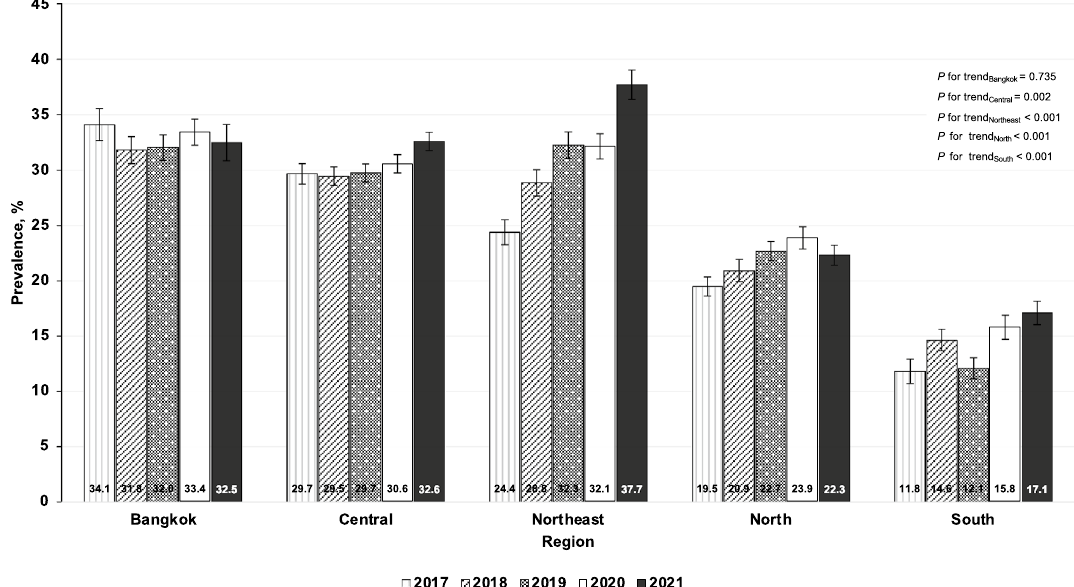
Figure 5. Age- and sex-adjusted prevalence (%) of the intermediate-to-high predicted 10-year risk for cardiovascular diseases (CVD) among Royal Thai Army personnel stratified by region from 2017 to